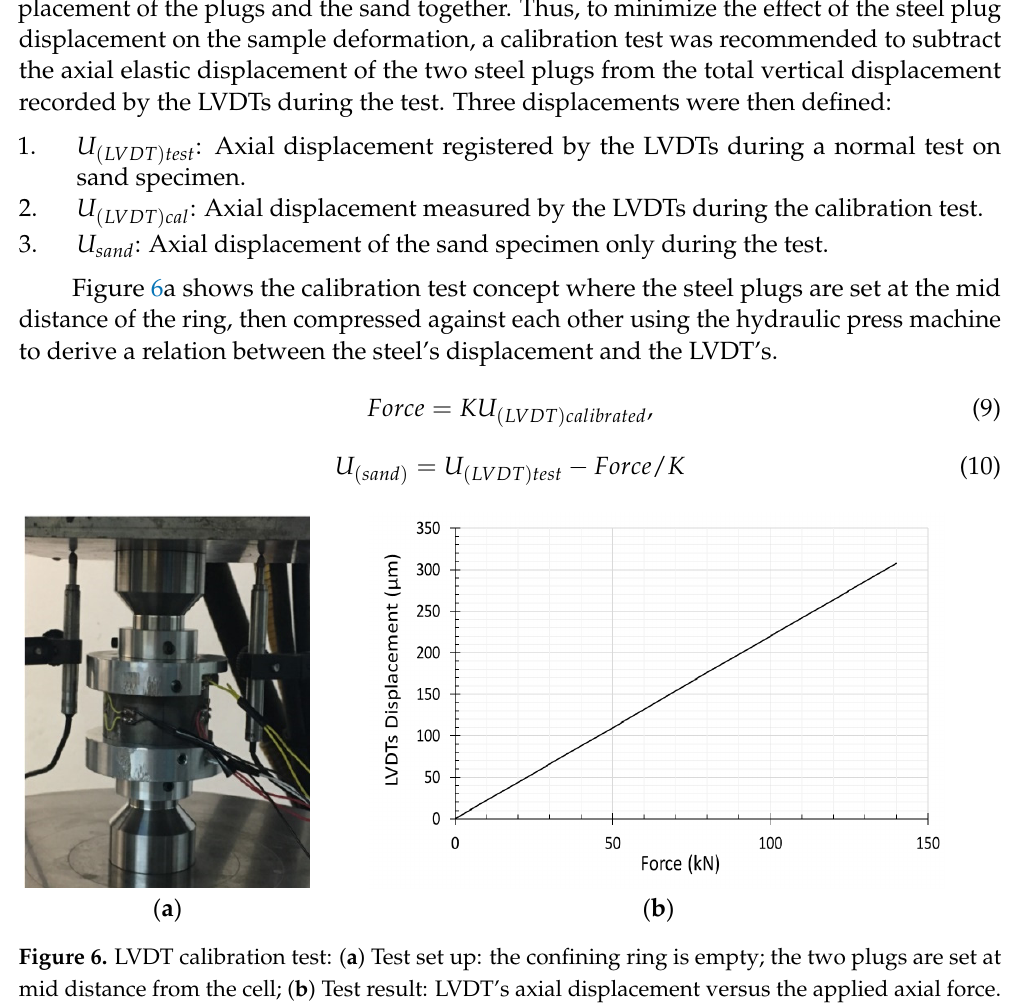
Figure 7. Steel ring calibration test; strain displacements were recorded by four gauges, fixed on the outer wall of the steel vessel (see Figure 2b), as a function of the applied vertical force.